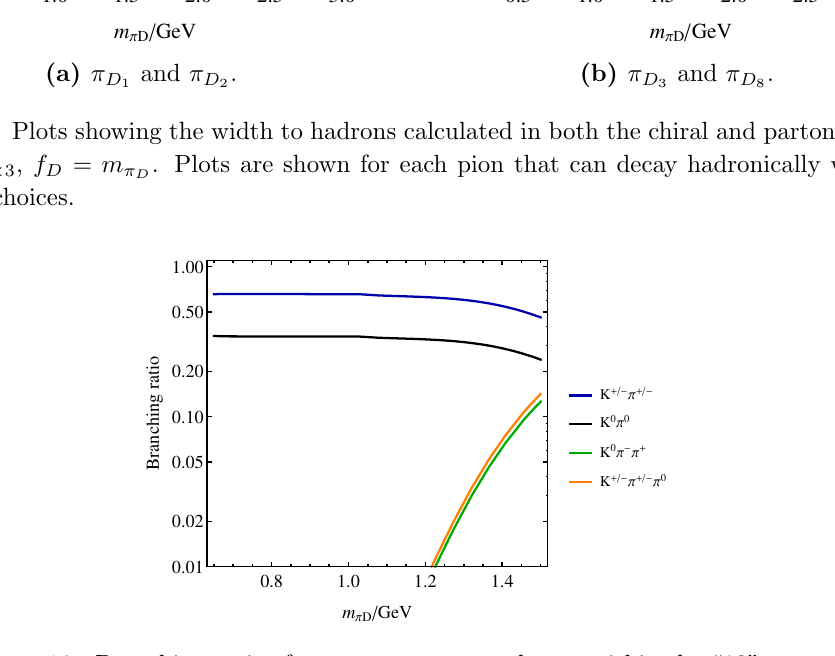
Figure 12. Branching ratios for (cid:25) D 1 , (cid:25) D 2 , (cid:25) D 6 and (cid:25) D 7 , within the \13" scenario.